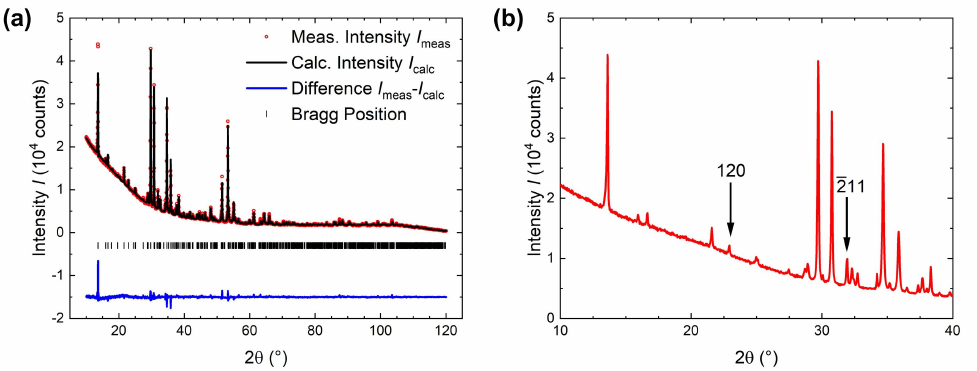
Figure 5. ( a ) pXRD pattern from powdered AgCrP 2 S 6 crystals compared to the calculated pattern based on the refined crystal structure model. ( b ) Zoomed-in view on the low angle 2 θ regime (10–40 ◦ ). The marked reflections are expected to be systematically absent assuming a crystal structure in the space group of C 2/ m instead of P 2/ a